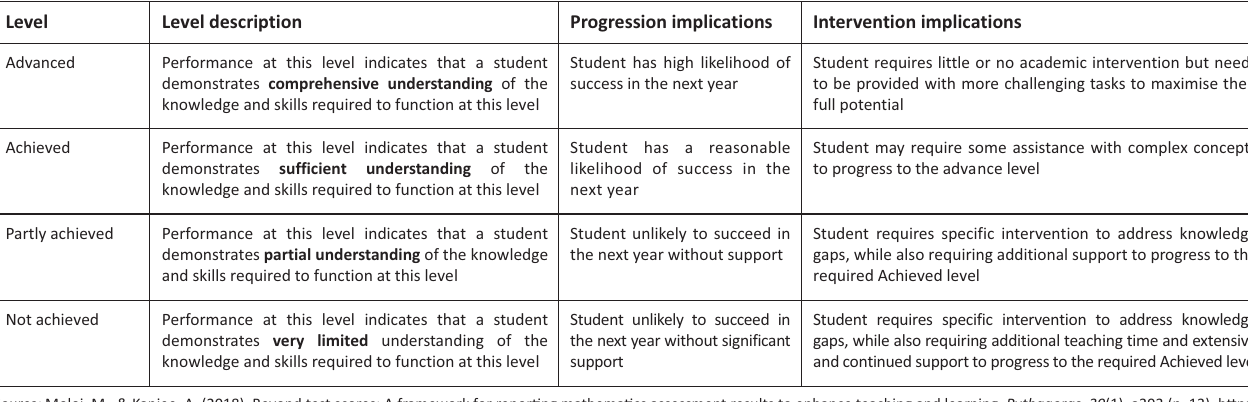
FIGURE 3: Generic performance level